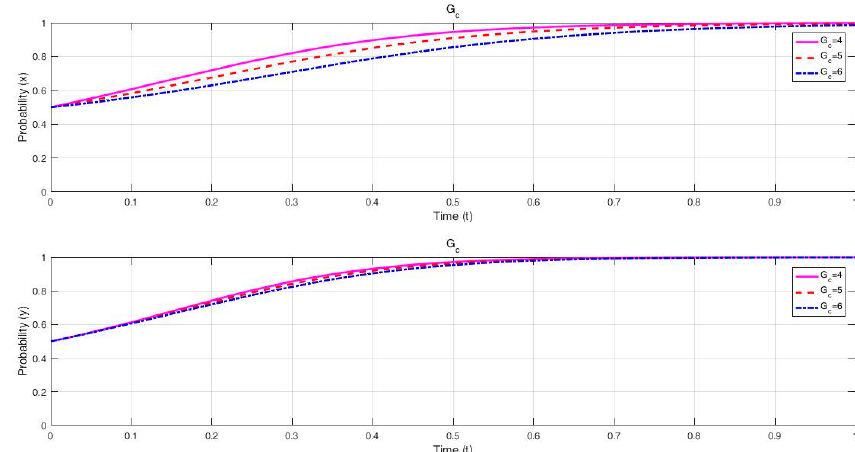
Figure 7. The impact of G c on the game.